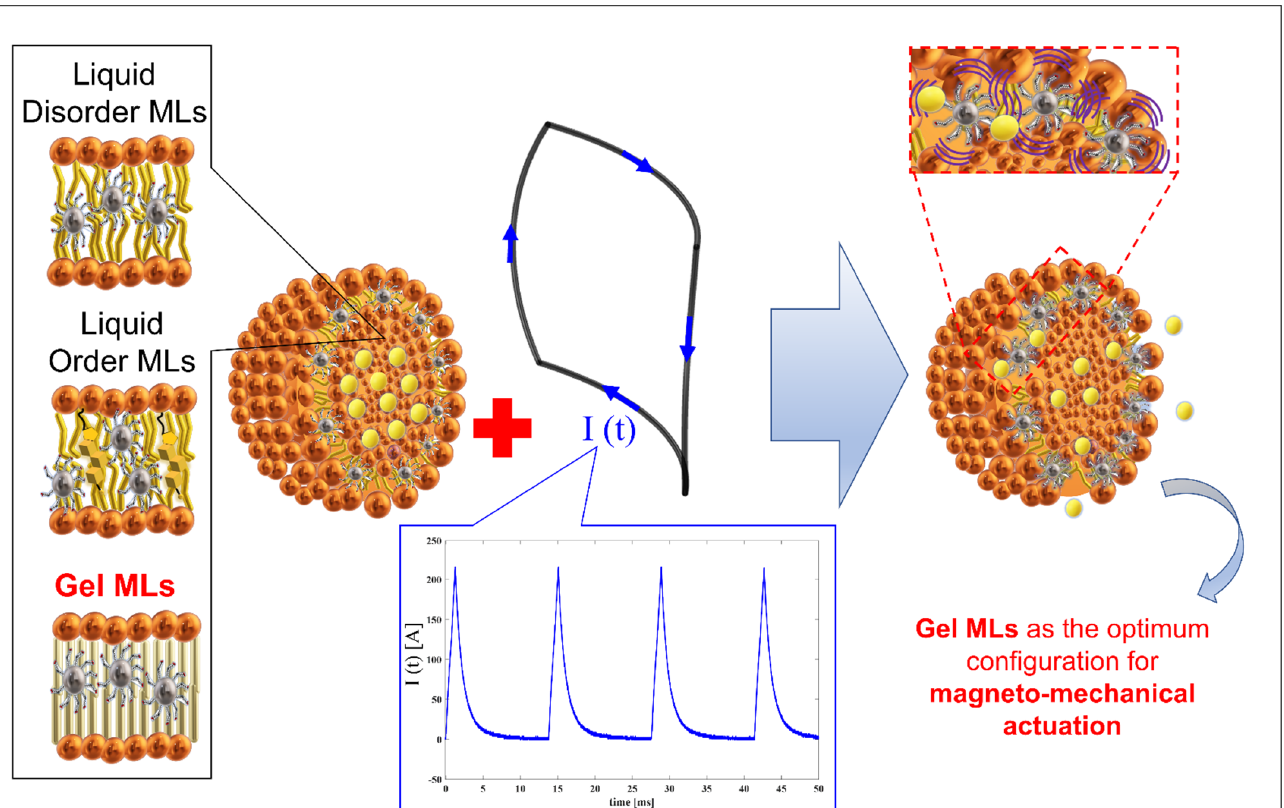
Figure 9. Scheme of the hypothesized mechanism of magneto-mechanical actuation based on PEMFs coupling with MLs. The current flowing in the coil produces the B field, which promotes oscillation of MNPs inside the bilayer of Gel MLs (organized with a rigid order packing) and finally destabilization of the membrane vesicle with release of its